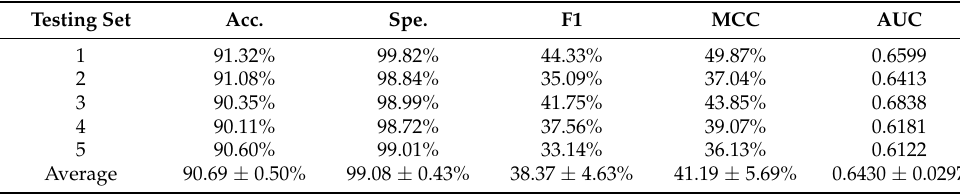
Table 2. The FFCV outcomes attained using SIPGCN in the yeast data set. Testing